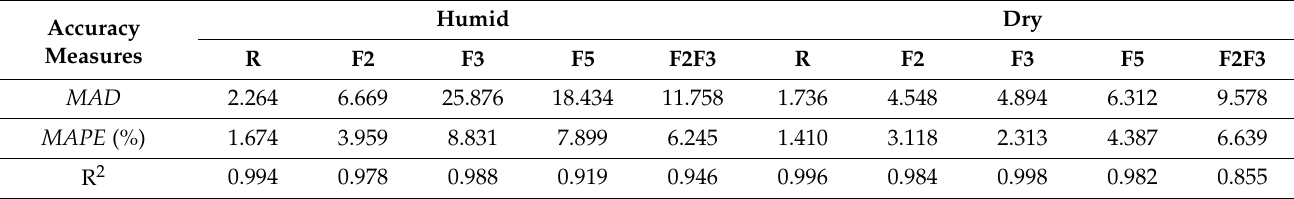
Table 12. Efficiency of linear patterns for various types of